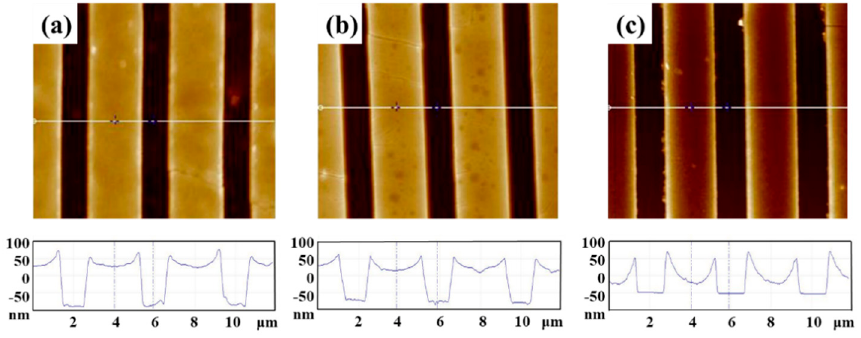
Figure 2. AFM images of PMMA/Ti 4+ lines obtained with different coating speed: ( a ) 2000 rpm, ( b ) 4000 rpm and ( c ) 8000 rpm.